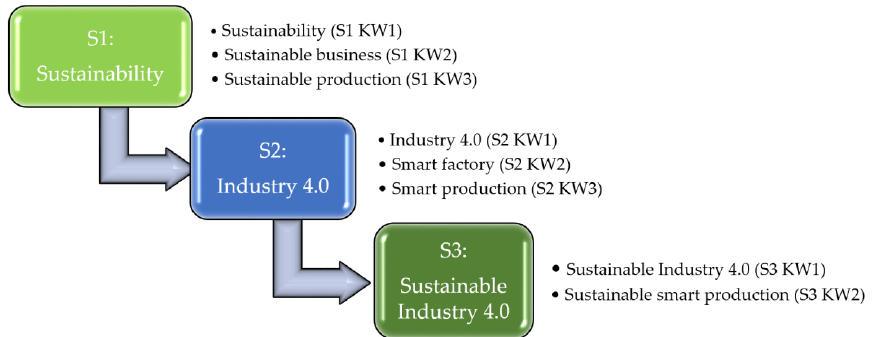
Figure 2. Segments of bibliometric analysis. Source: Own study.